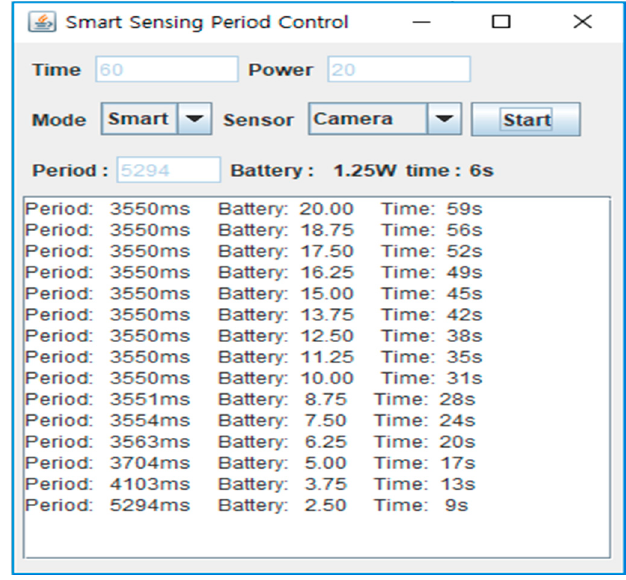
Figure 10. Screenshots of smart sensing in camera sensor.